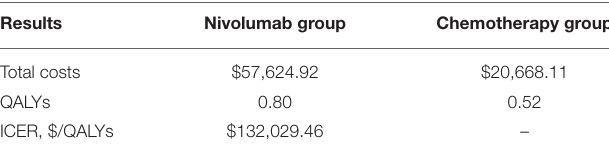
TABLE 3 | Results of our